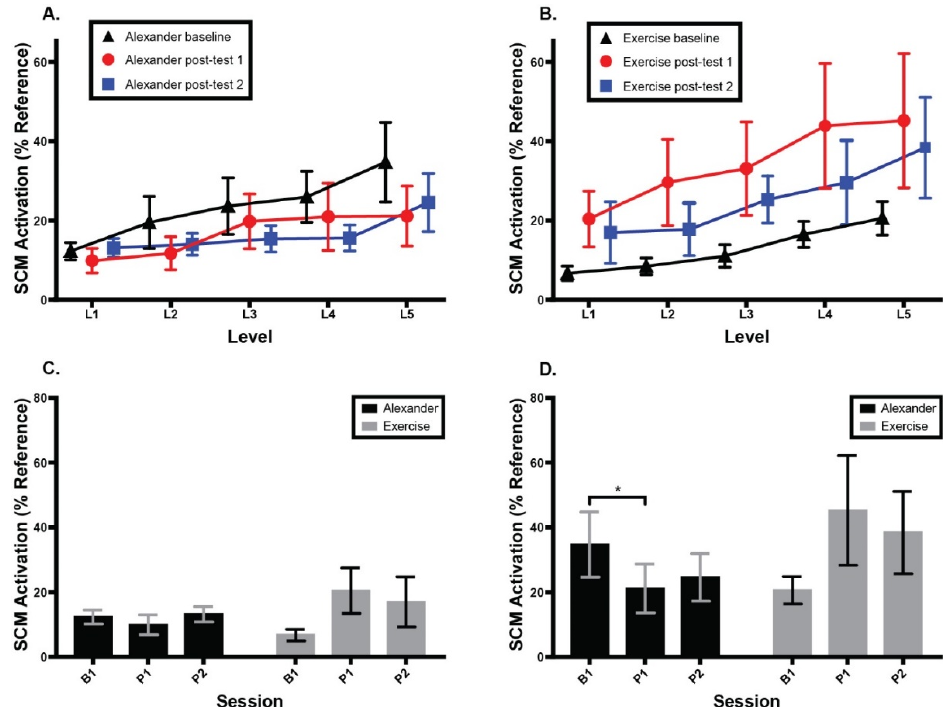
Figure 6. Normalized bilateral sternocleidomastoid (SCM) muscle activity as a percent of accepted voluntary contraction during cranio-cervical flexion test (CFFT). ( A ) Alexander group SCM activity across three testing sessions and five CCFT levels. ( B ) Exercise group SCM activity across three testing sessions and five CCFT levels. ( C ) SCM activity across groups and sessions at CCFT Level 1. ( D ) SCM activity across groups and sessions at CCFT Level 5. Error bars indicate the standard error of the mean. * signifies p < 0.05. B1 = baseline; P1 = 1st post-test; P2 = 2nd